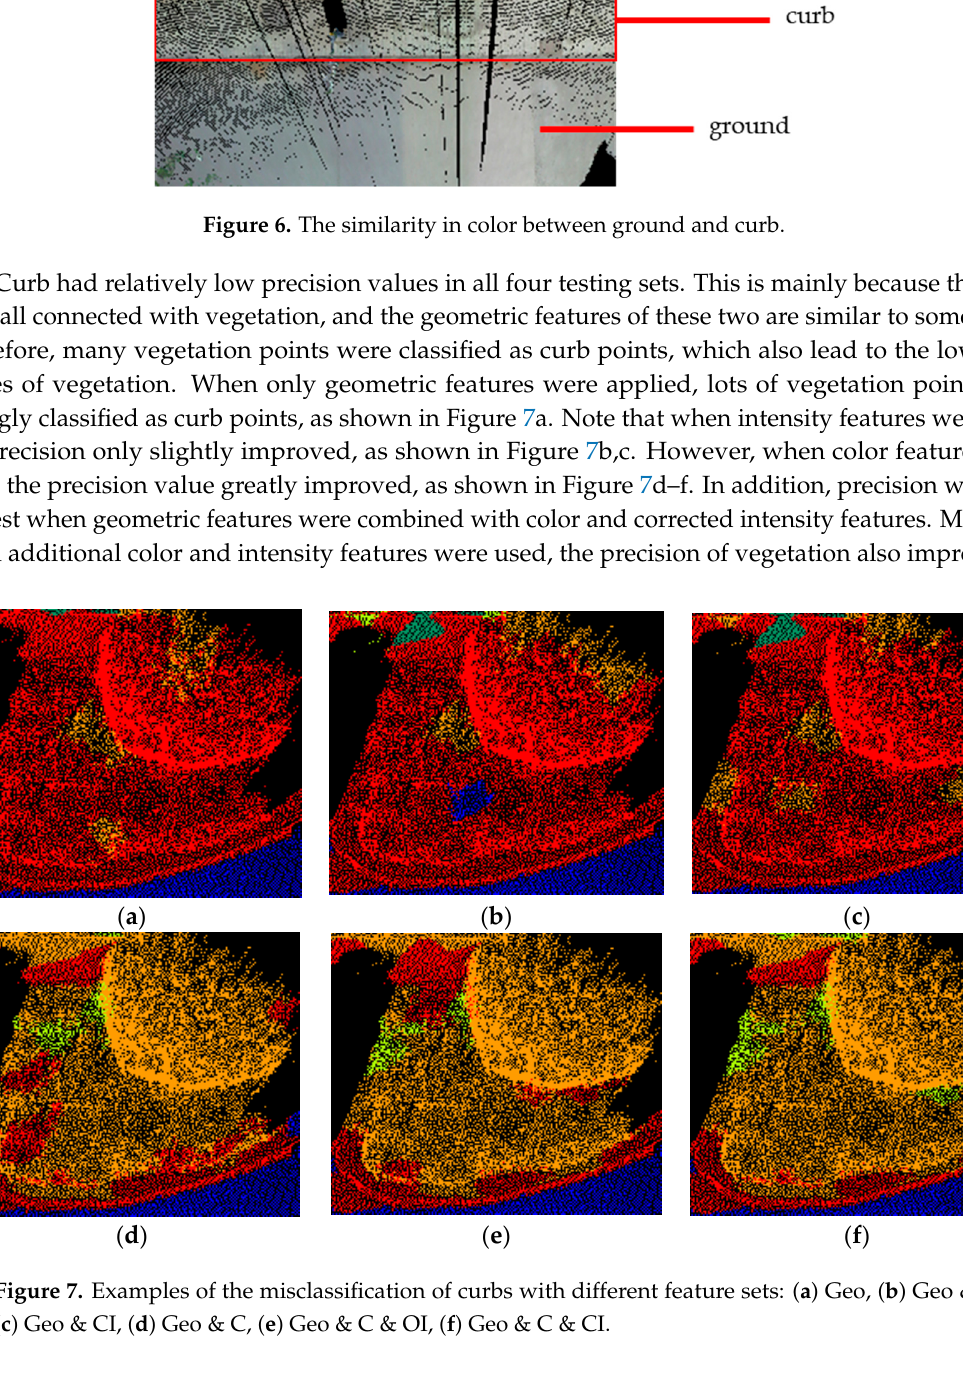
Figure 5. Examples of the misclassification between façades and trees with different feature sets: ( a ) Geo, ( b ) Geo & C.